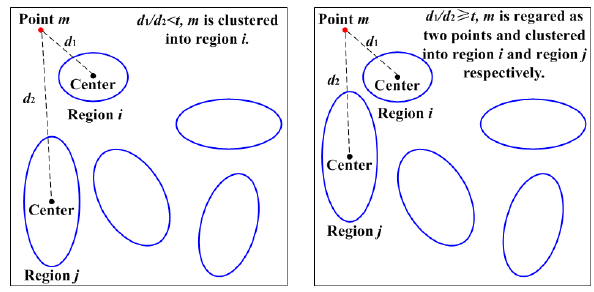
Figure 4. Interest points clustering rule.